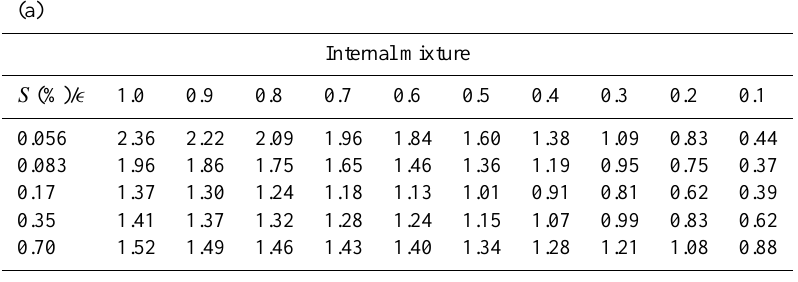
Table 1. Ratio of calculated to observed CCN number concentration on average at five supersaturations ( S) for different ammonium sul- fate mass fraction ( ε) and mixing state. For each setup of the composition, we also calculated the averaged CCN cal /CCN obs over all the supersaturations. The kinetic model is used and the mass accommodation coefficient of water is 0.04.